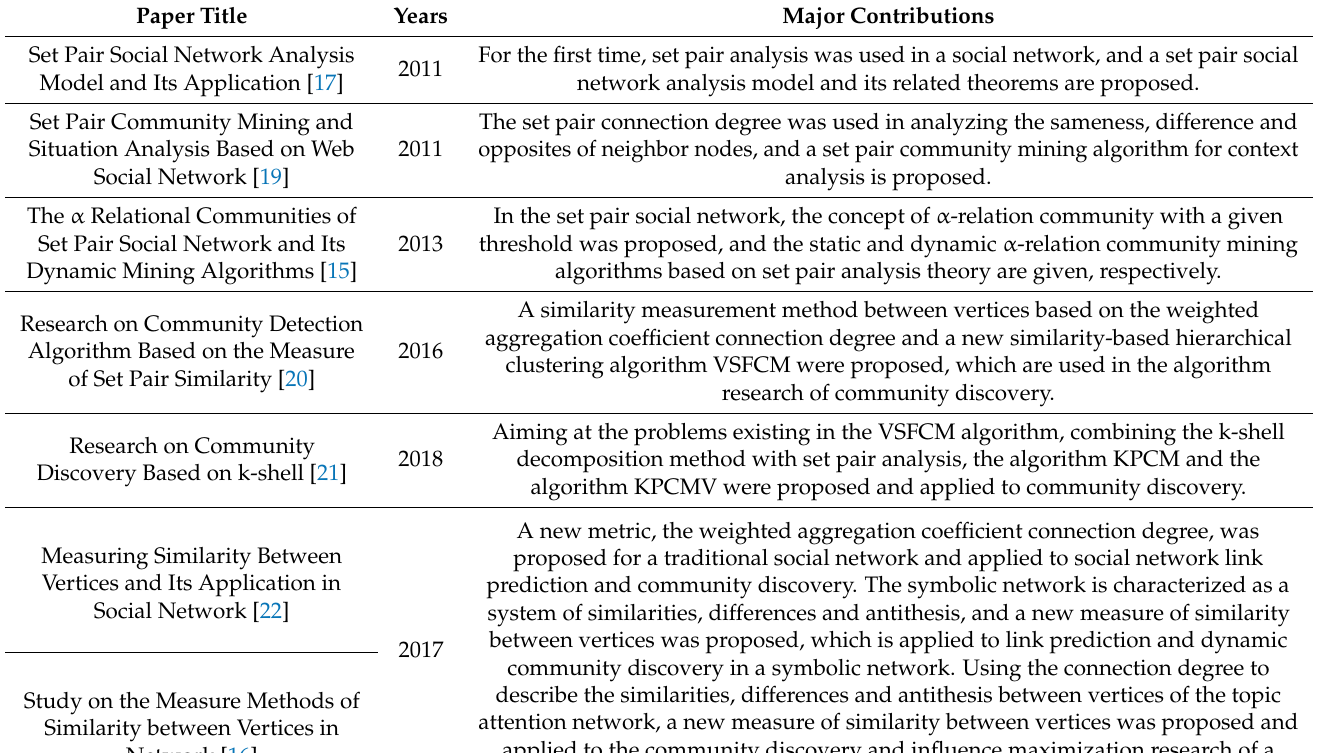
Table 1. The current research situation of set pair analysis in social